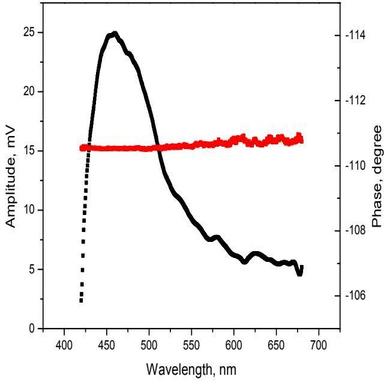
The amplitude (black) and the phase (red) of the PPES signal of the empty sensor used for the normalization purpose measured at the modulation frequency of 10 Hz. (For interpretation of the references to colour in this figure legend, the reader is referred to the web version of this article.)